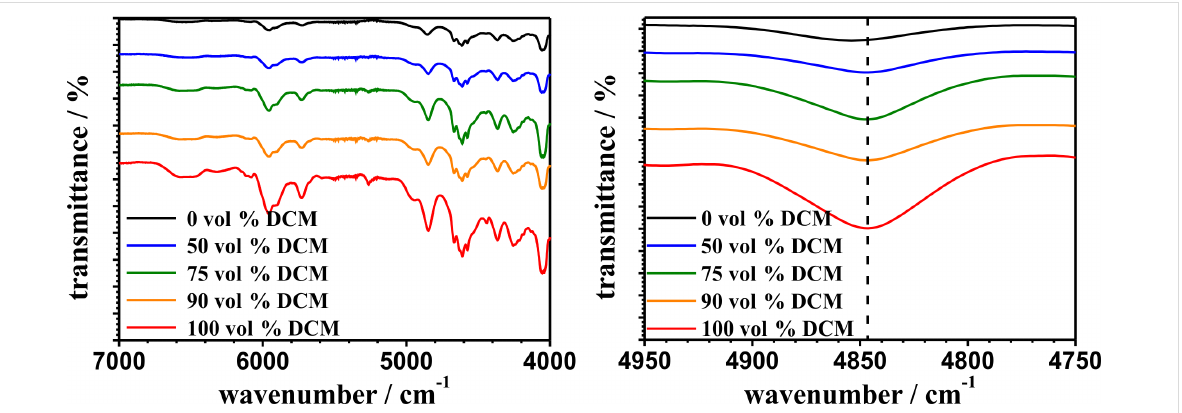
Figure 7: NIR spectra of the polyphenylalanine functionalized ALOX-membranes obtained from different solvent mixtures at different wavenumber regions after the grafting process. The dotted line indicates the maxima of the combination band at 4847 cm − 1 of the polyphenylalanine functionalized membrane from pure DCM.